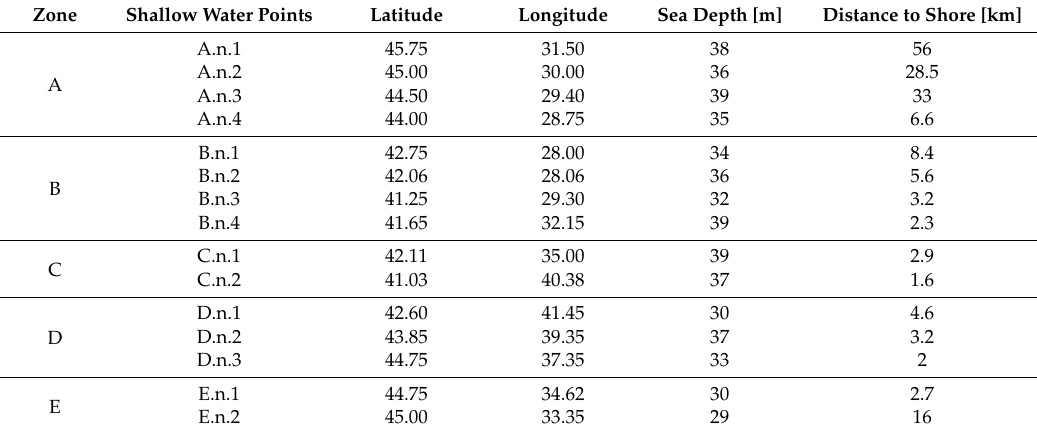
Table 1. The geographical locations and the characteristics of the shallow water points. Zone